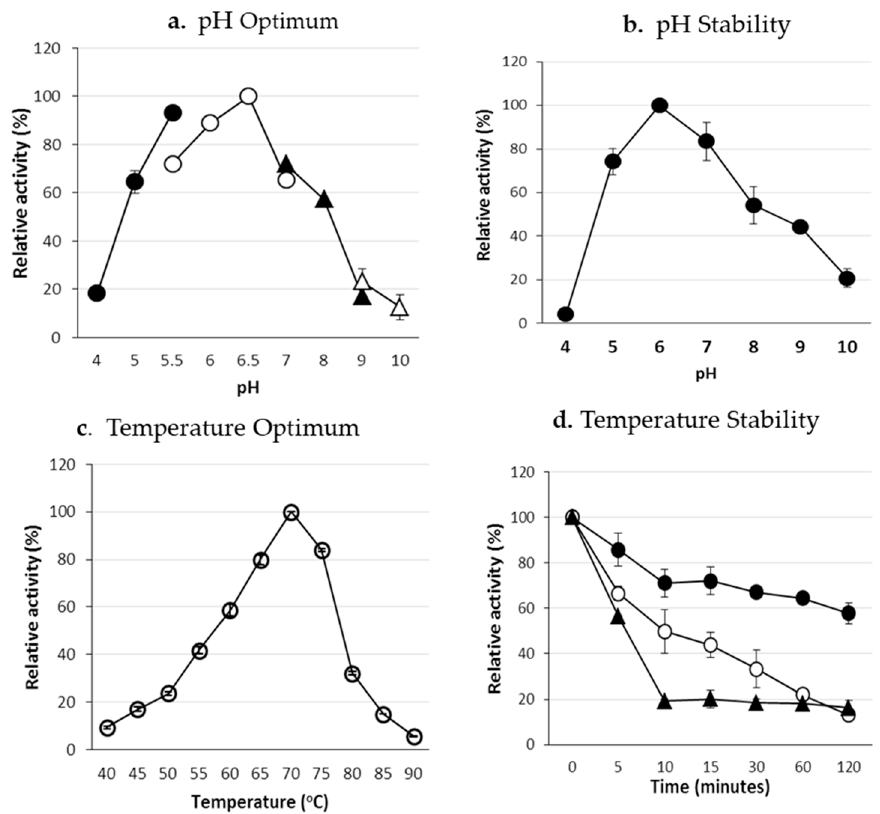
Figure 5. Characterization of the purified ManNj6-379. ( a ) Effect of pH on ManNj6-379. The assay was performed at 50 °C in buffers with pH ranging from 4.0 to 10.0. Symbols: sodium acetate buffer (black dot); MES-NaOH buffer (white dot); Tris-HCl buffer (black triangle); glycine-NaOH buffer (white triangle). ( b ) pH stability of ManNj6-379. After pre-incubating the enzyme at 50 °C for 60 min in buffers of pH 4.0-10.0, the activity was measured in MES-NaOH buffer (pH 6.0) at 50 °C. Temperature optimum ( c ) and thermostability of ManNj6-379 ( d ). The enzyme was preincubated at 50 °C (black dot), 60 °C (white dot), or 70 °C (black triangles) in 50 mM MES-NaOH buffer (pH 6.0).